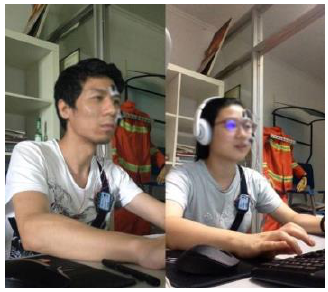
Figure 1. Experimental